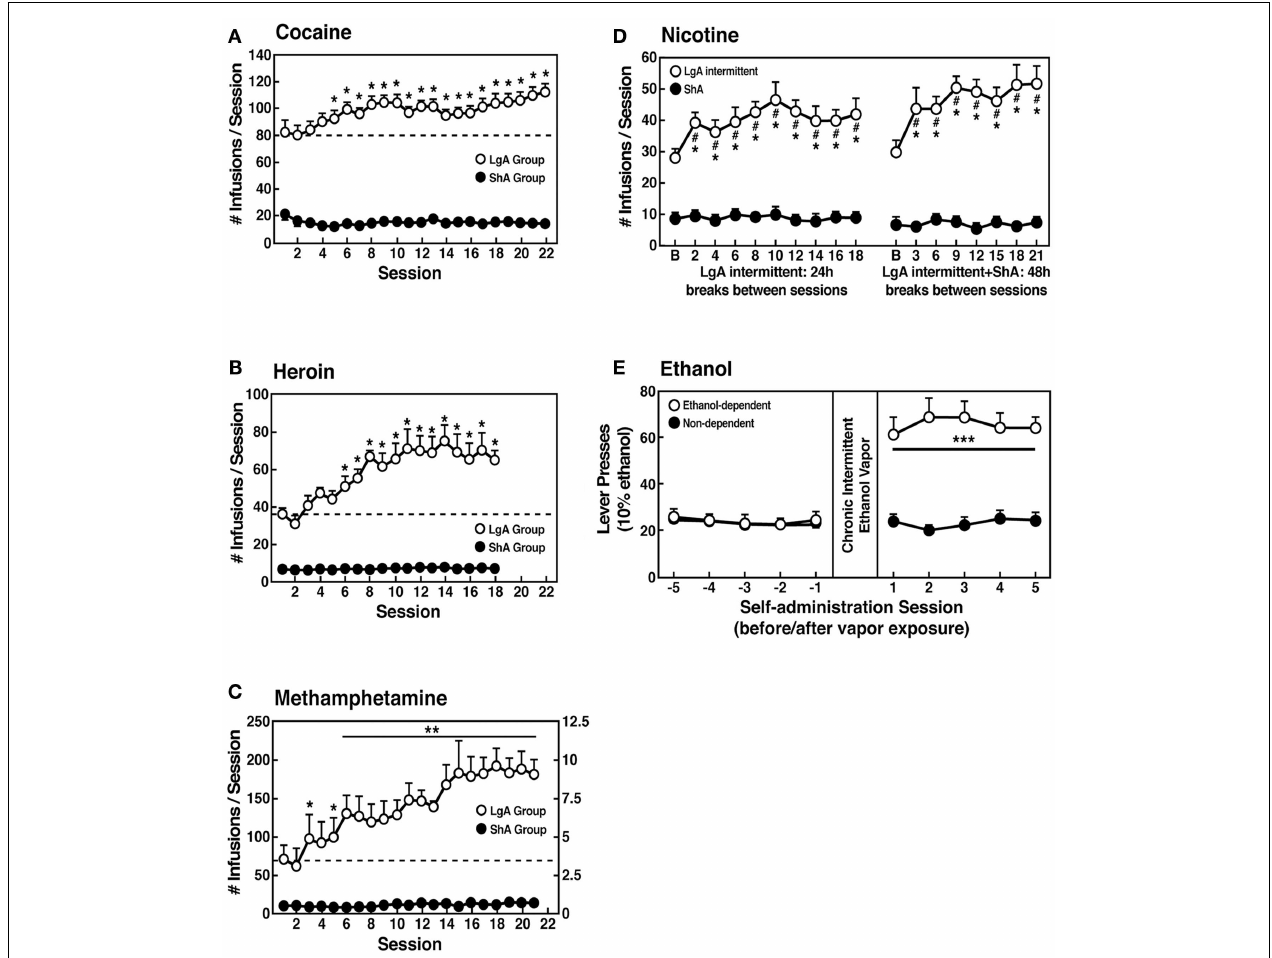
FIGURE 4 | (A) Effect of drug availability on cocaine intake (mean ± SEM). In long-access (LgA) rats ( n = 12) but not short-access (ShA) rats ( n = 12), the mean total cocaine intake started to increase significantly from session 5 ( p < 0.05; sessions 5–22 compared with session 1) and continued to increase thereafter ( p < 0.05; session 5 compared with sessions 8–10, 12, 13, and 17–22) [taken with permission from Ref. (74)]. (B) Effect of drug availability